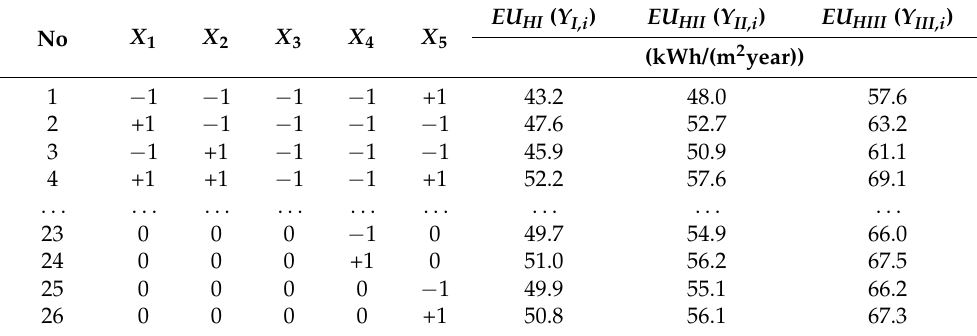
Table 6. Planning matrix and calculation results of EU HI (Y I , i ), EU HII (Y II.i ), EU HIII (Y III , i